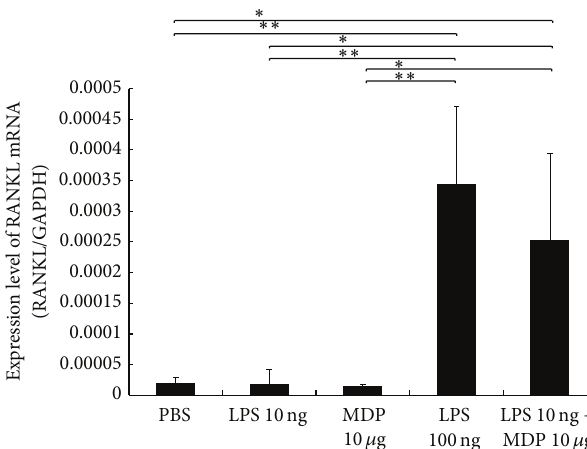
Figure 4: Enhancing lipopolysaccharide- (LPS-) induced receptor activator of NF- 𝜅 B ligand (RANKL) expression by muramyl dipep- tide (MDP) in vivo . Total RNA from mouse calvariae was isolated after 5 days of daily supracalvarial injections of PBS, LPS (10 𝜇 g/day), MDP (100 𝜇 g/day), LPS (100 𝜇 g/day), or LPS (10 𝜇 g/day) + MDP (100 𝜇 g/day). mRNA levels for RANKL were normalized to those of GAPDH. Results are expressed as mean ± SD ( 𝑛 = 4 ; ∗∗ 𝑃 < 0.01 ). Differences were determined using Scheffe’s 𝐹 test.